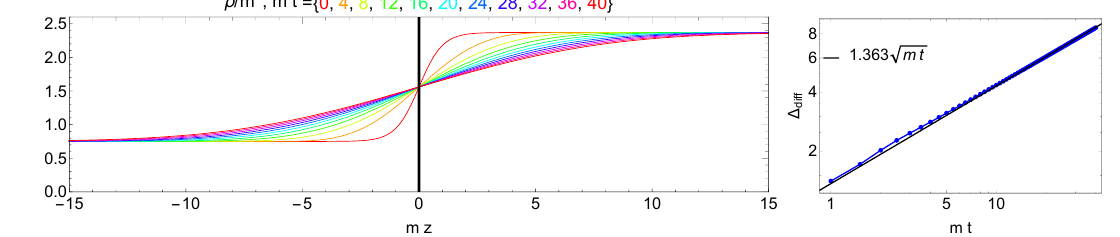
Figure 9: Left: Diffusion of the charge density in a heat bath with constant temper- ature. Right: Evolution of the charge diffusion width ∆ result extracted form the numerical simulation and the black line the analytical